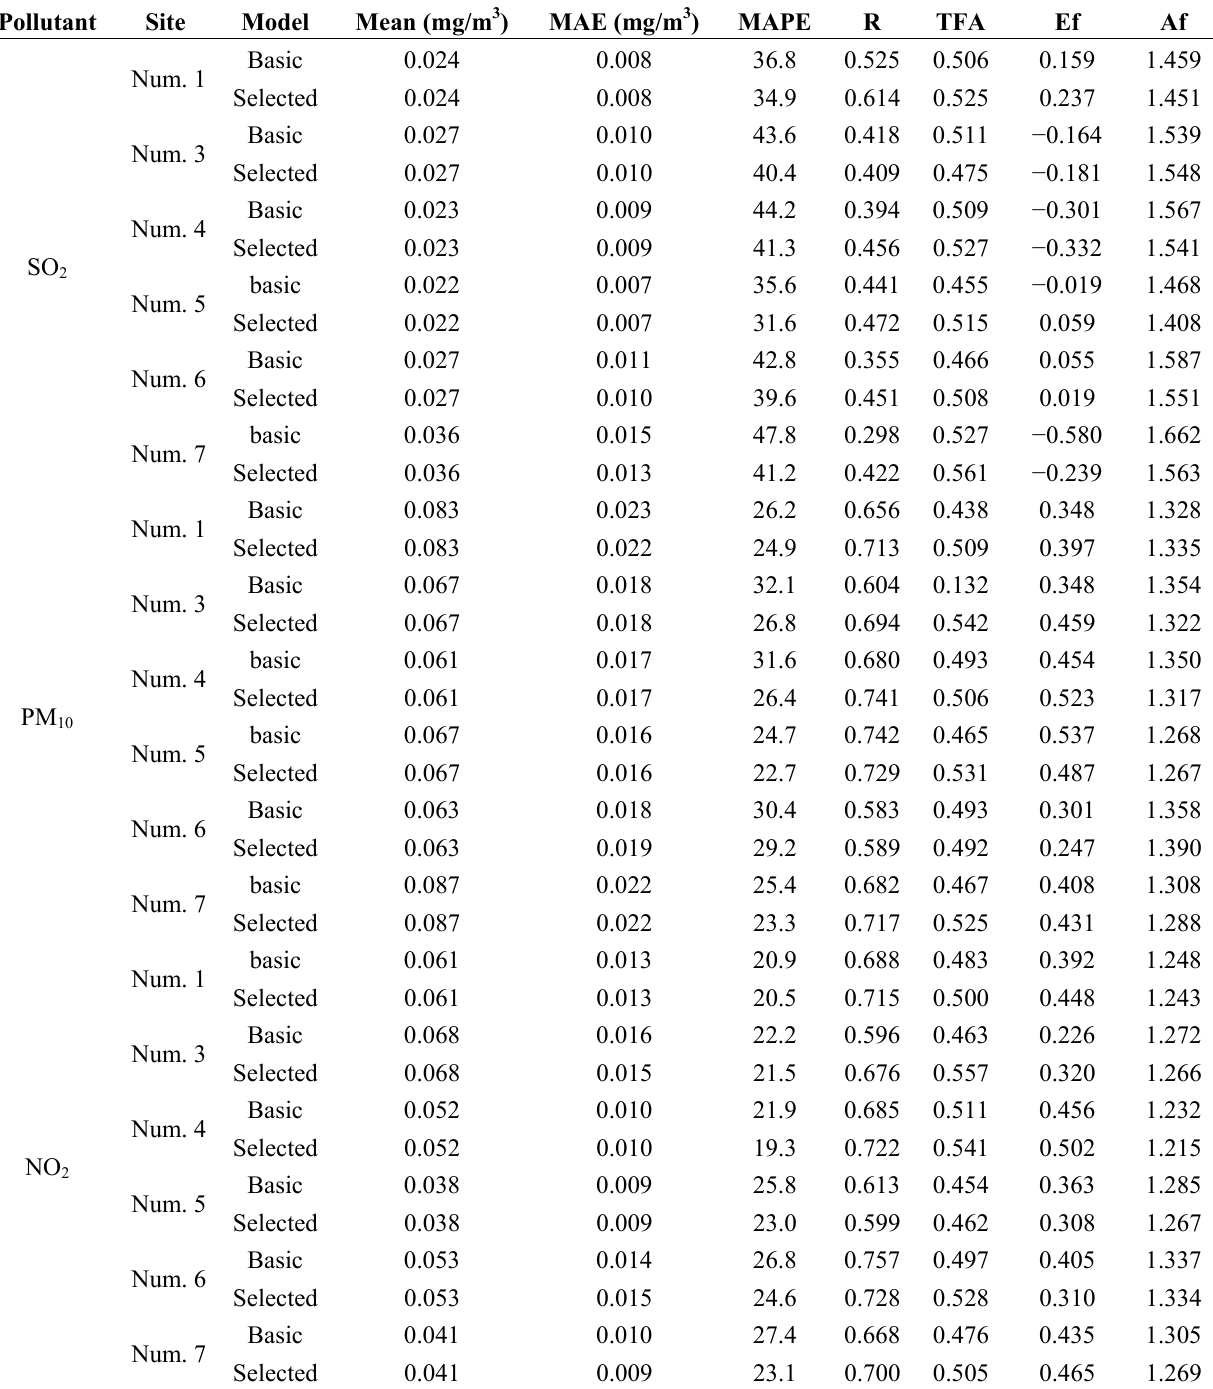
Table 2. Comparisons between the Selected and Basic Model in the remaining six sites. Pollutant